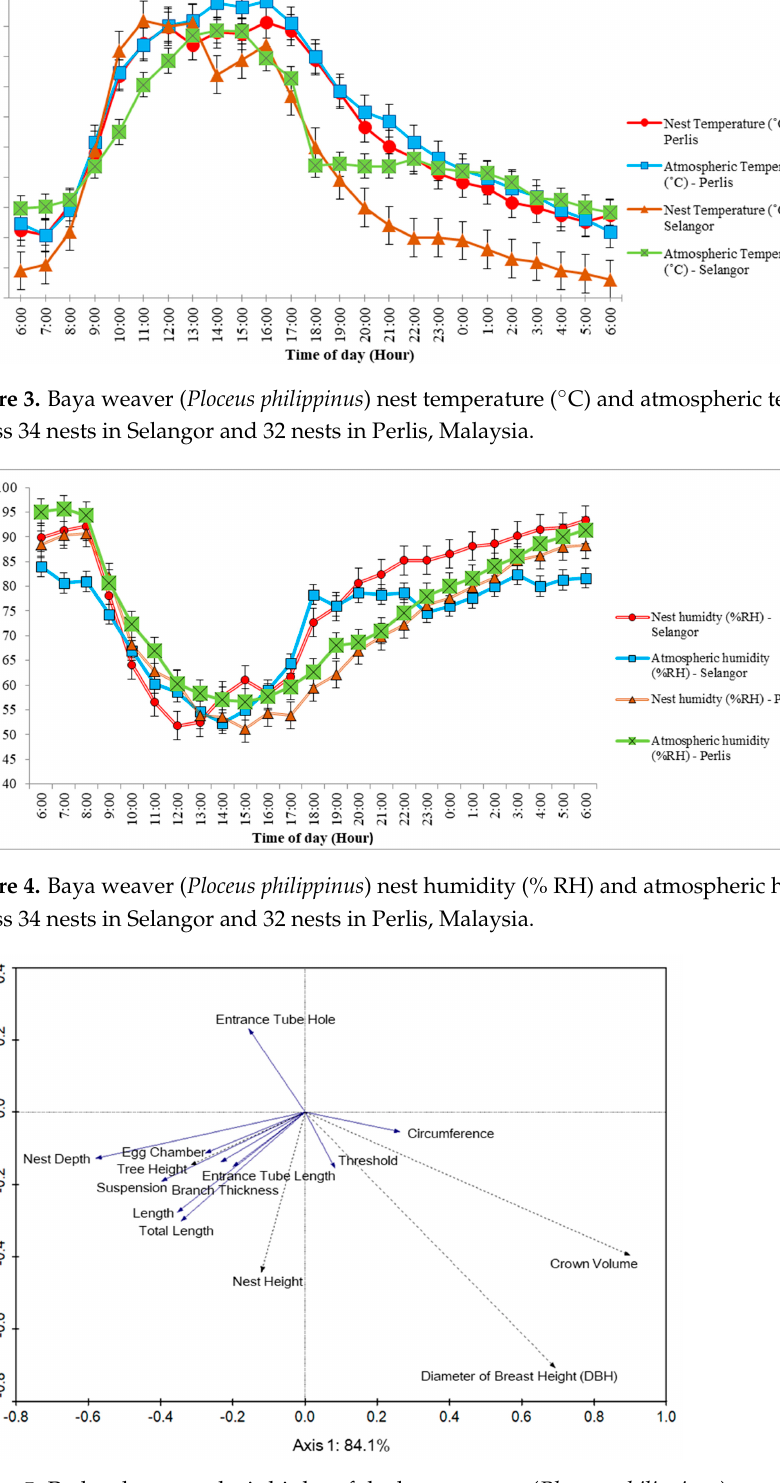
Figure 5. Redundancy analysis biplot of the baya weaver ( Ploceus philippinus ) nest structure (solid line vectors) and nest tree variables (dotted line vectors) for the Selangor site. Arrows indicate the direction that the nest structure increased in measurement whereas the angles between variables approximate their